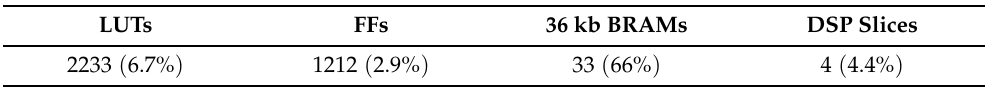
Table 10. IOb-SoC with ECG-ID-BNet parameters and firmware pre-loaded FPGA resource utilization (relative to FPGA’s resources).